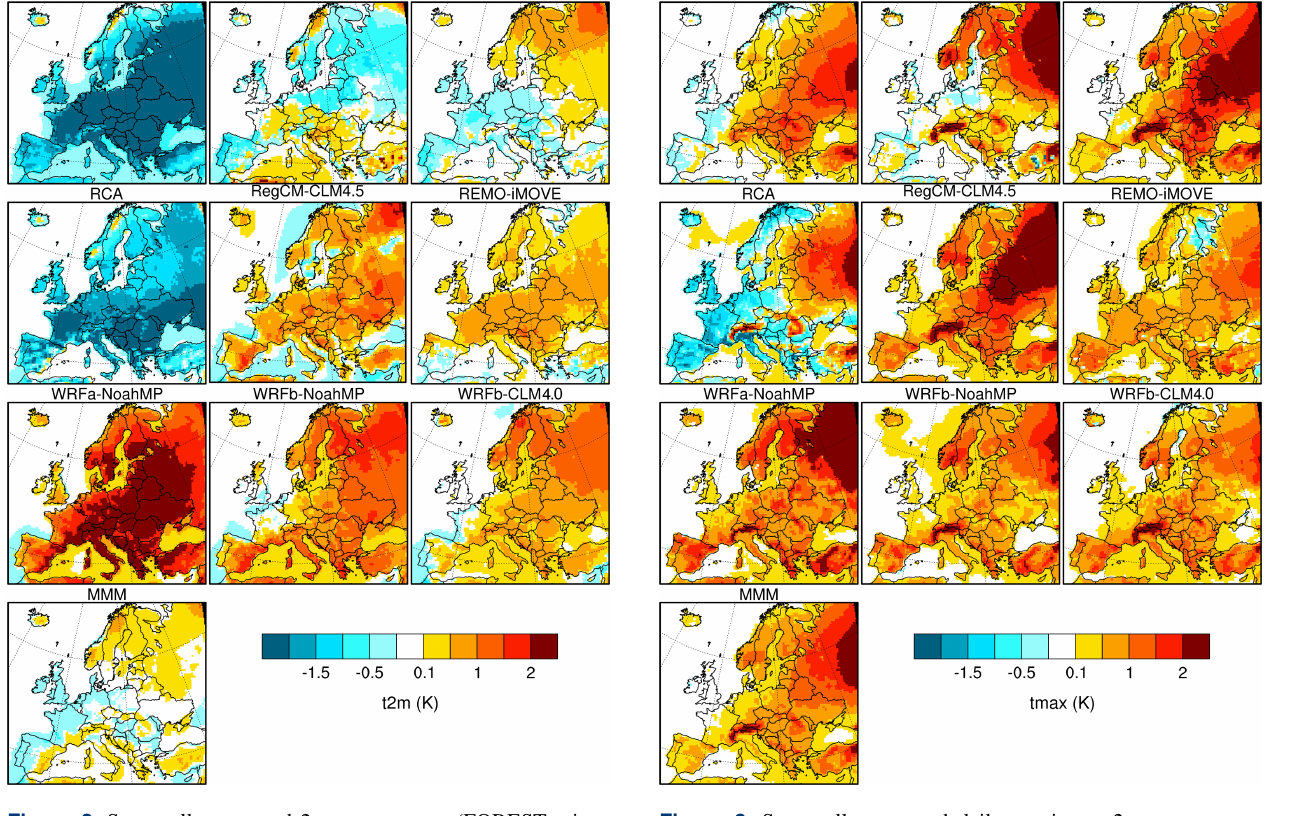
Figure 2. Seasonally averaged 2m temperature (FOREST minus GRASS) for summer (JJA).